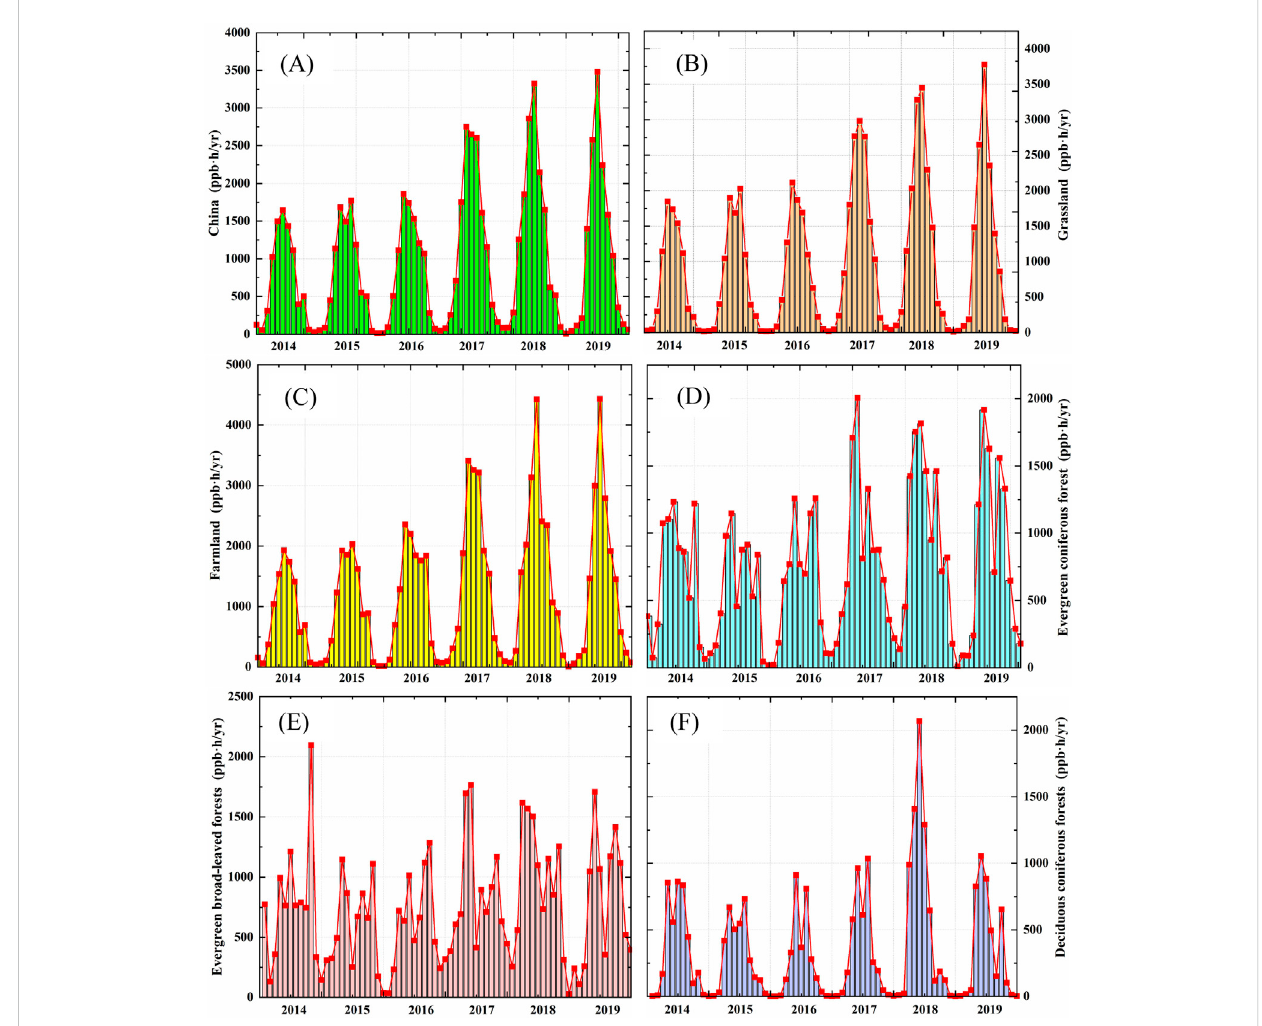
Monthly AOT40 spatial distribution, 2014 – 2019, (A – F) are China, Grassland, Farmland, Evergreen coniferous forests, Evergreen broad-leaved forests, Deciduous coniferous